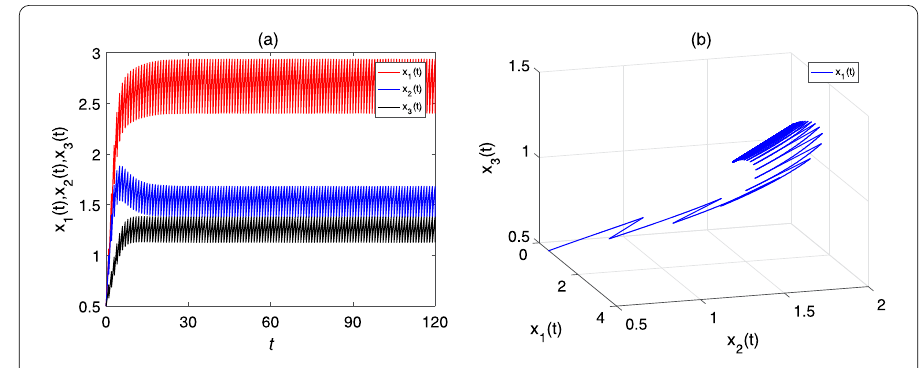
Figure 1 (a) is the time sequence diagram and (b) the phase portrait of system (2) without stochastic perturbations and impulse.( x 1 (0), x 2 (0), x 3 (0)) = (0.5,0.5,0.5), σ 2 1 ( t ) = σ 2 2 ( t ) = σ 2 3 ( t ) = 0